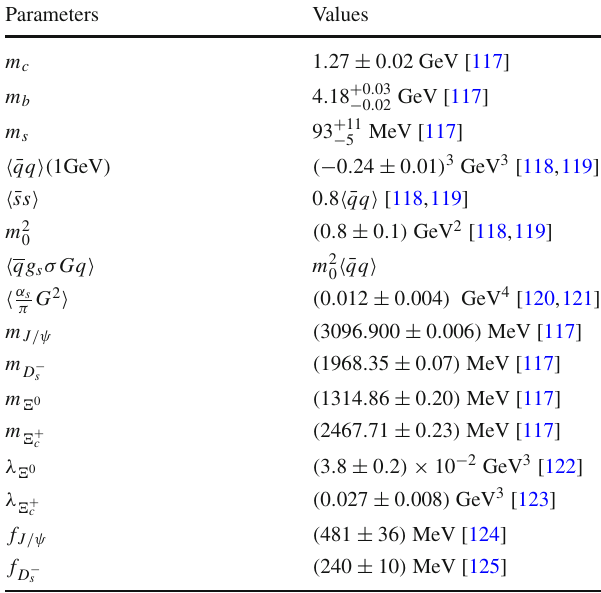
Table 1 Some input parameters used in the analyses of mass and cou- pling constants